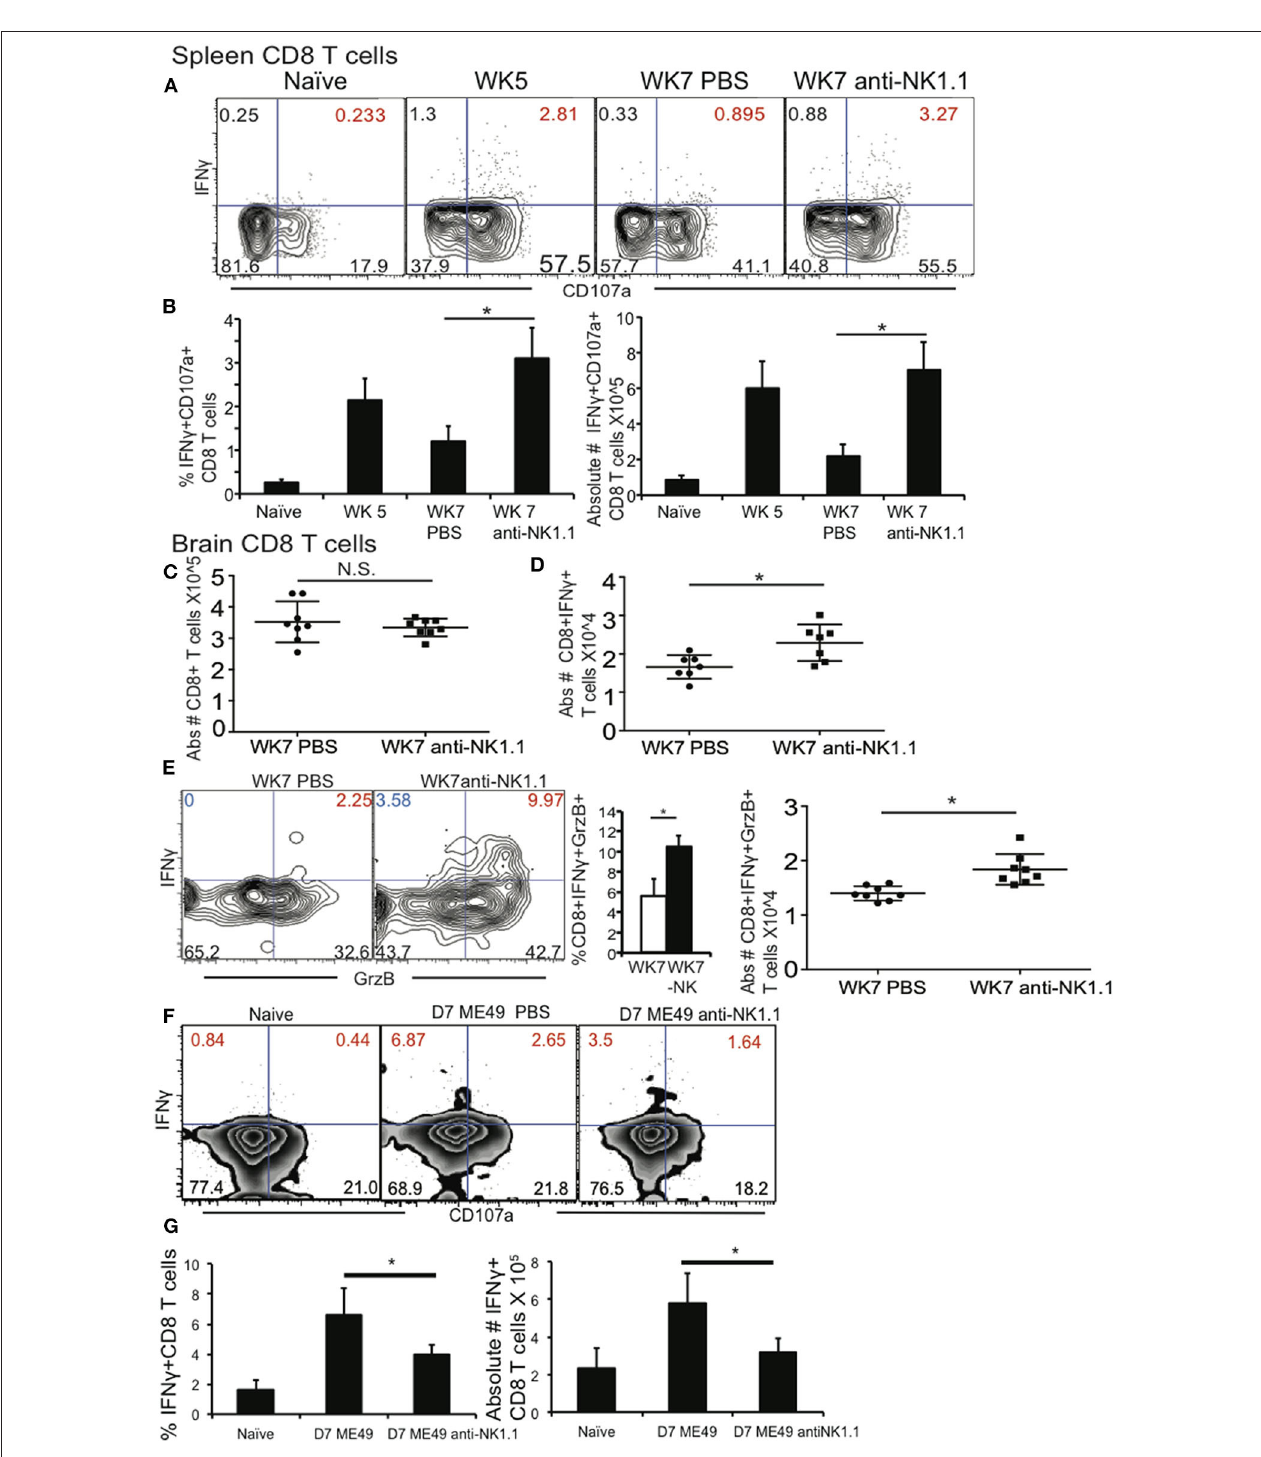
FIGURE 3 | NK cells reduce polyfunctional CD8 + T cells by increasing their apoptosis during chronic T. gondii infection. C57BL/6 mice were infected as described and 5 weeks after infection treated with 200 µ g anti-NK1.1 or 200 µ l 1 X PBS i.p. Brain and spleen cells were harvested and restimulated ex vivo with TLA. (A) Contour plots present spleen CD8 + T cells analyzed for IFN γ + × CD107a + . (B) Graphs present frequency and absolute # of polyfunctional IFN γ + CD107a + CD8 + T cells. Data presented is from 1 experiment repeated independently 2 times with n = 5 mice per group. (C) Graphs present pooled data from 2 independent experiments of absolute numbers of brain CD8 + T cells with or without anti-NK1.1 treatment starting at wk 5 post infection. (D) Graphs present pooled data